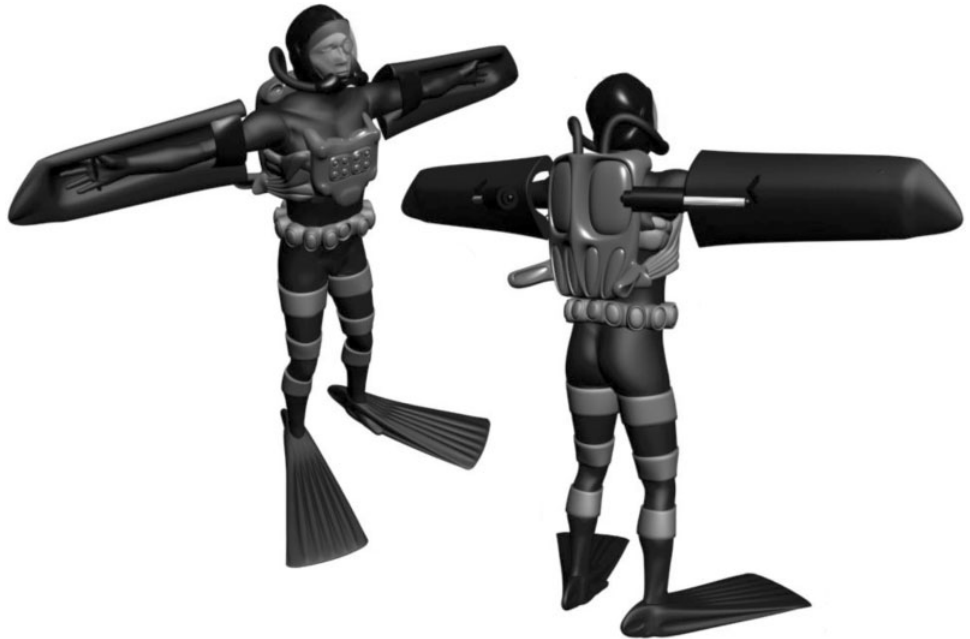
Figure 4 Human exoskeleton for biomimetic propulsion (Neuhaus et al . 2004). The human diver is envisioned to swim by flapping motion, which is similar to the propulsive strokes of certain fish, penguins, and sea lions. Drawing courtesy of P. D.